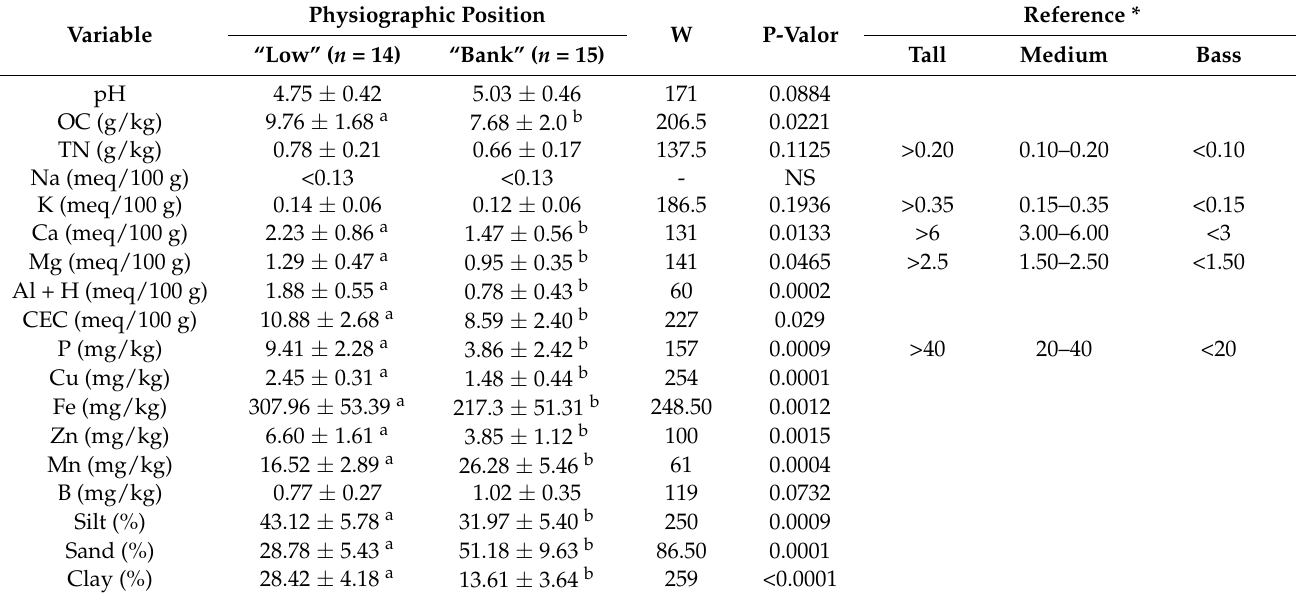
Table 2. Mean values for the chemical and physical variables according to the physiographic position in the Araucanian flooded savanna (Arauca, Colombia, 2021).